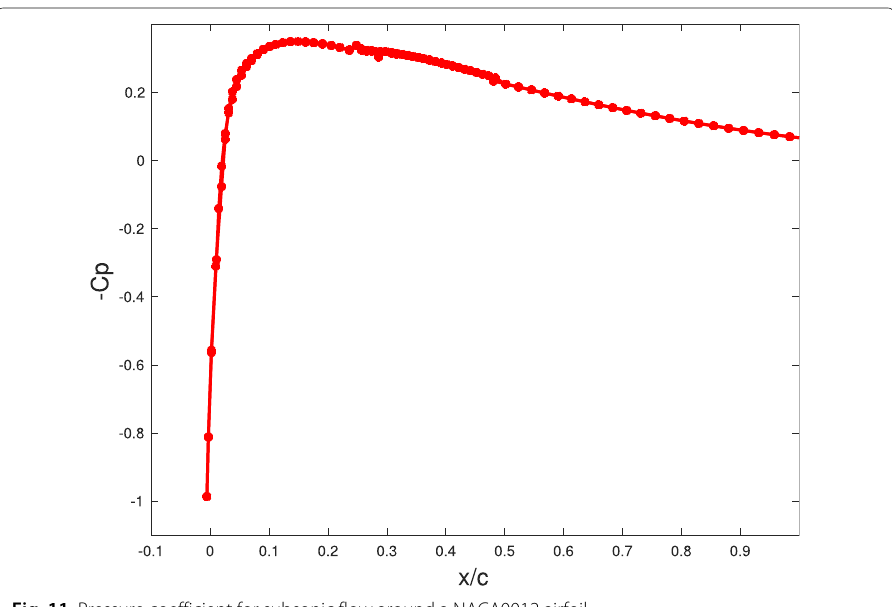
Fig. 11 Pressure coefficient for subsonic flow around a NACA0012 airfoil